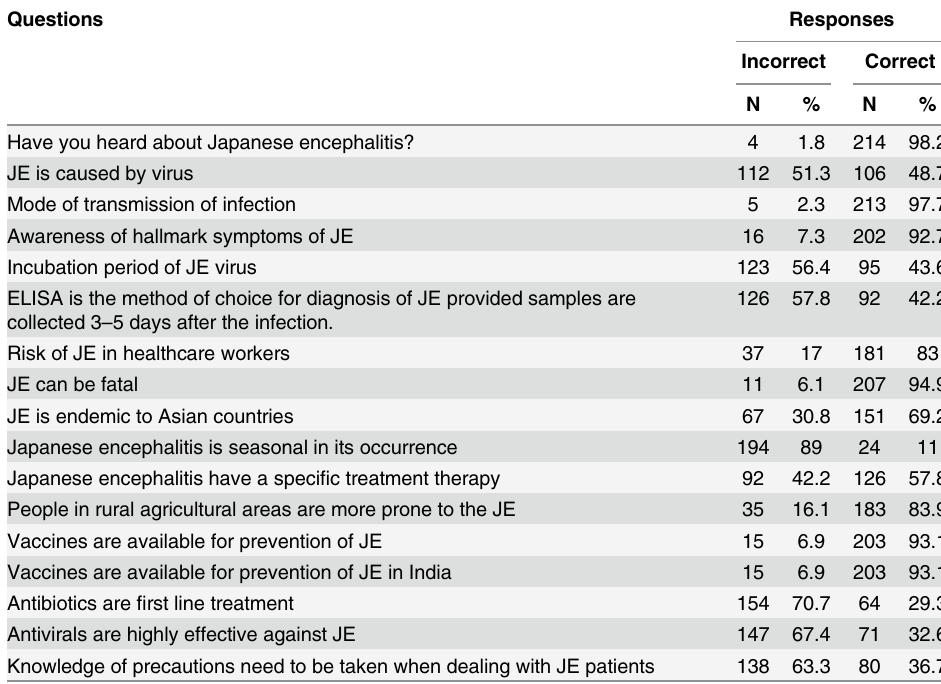
Table 2. Knowledge of HCWs towards Japanese Encephalitis (N =